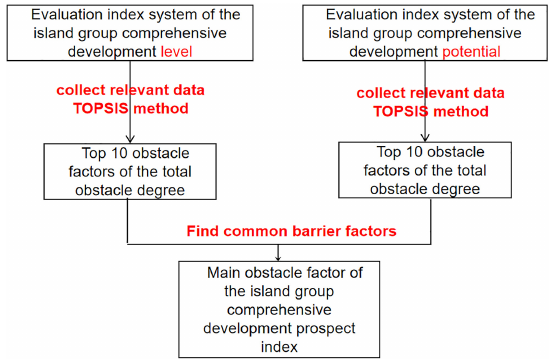
Figure 4. Process of